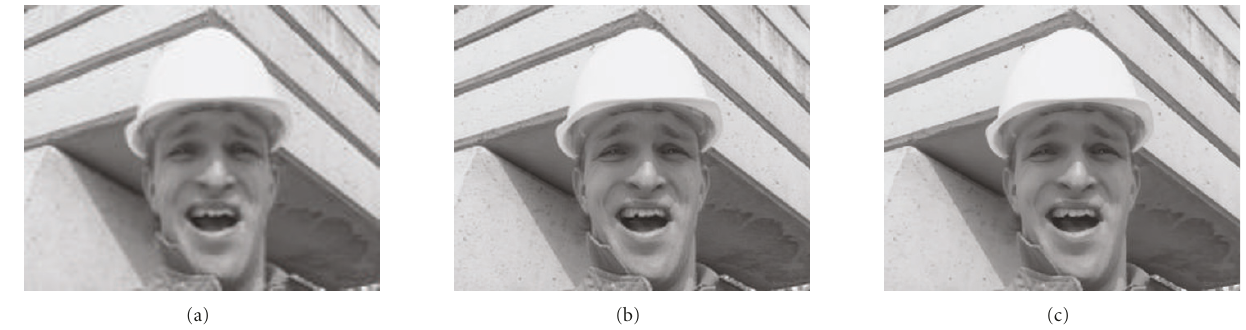
Figure 12: Experimental results in the nonsynthetic “motion only” case. (a) LR frame, (b) Laplacian SR result with λ = 0 . 008 and (c) TV SR result with λ = 0 .